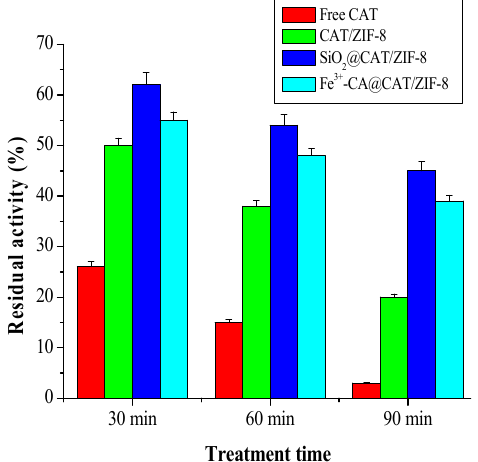
Figure 6. Acid tolerance (pH 3.0) of SiO 2 @CAT/ZIF-8 and Fe 3+ -CA@CAT/ZIF-8.